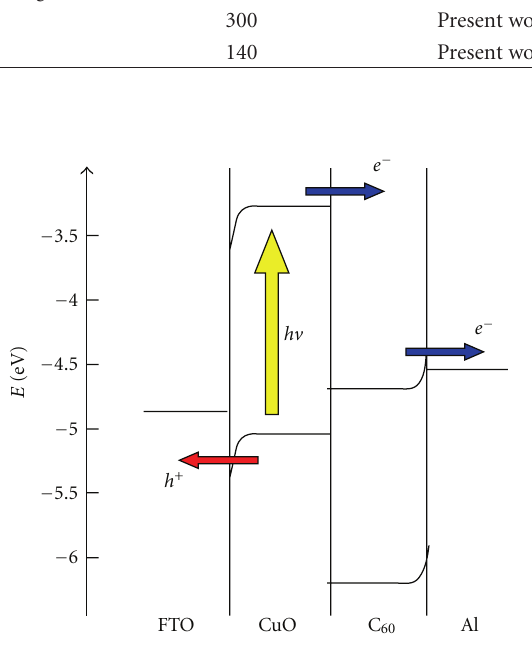
Figure 9: Energy level diagram of FTO/CuO/C 60 /Al heterojunction solar cells.